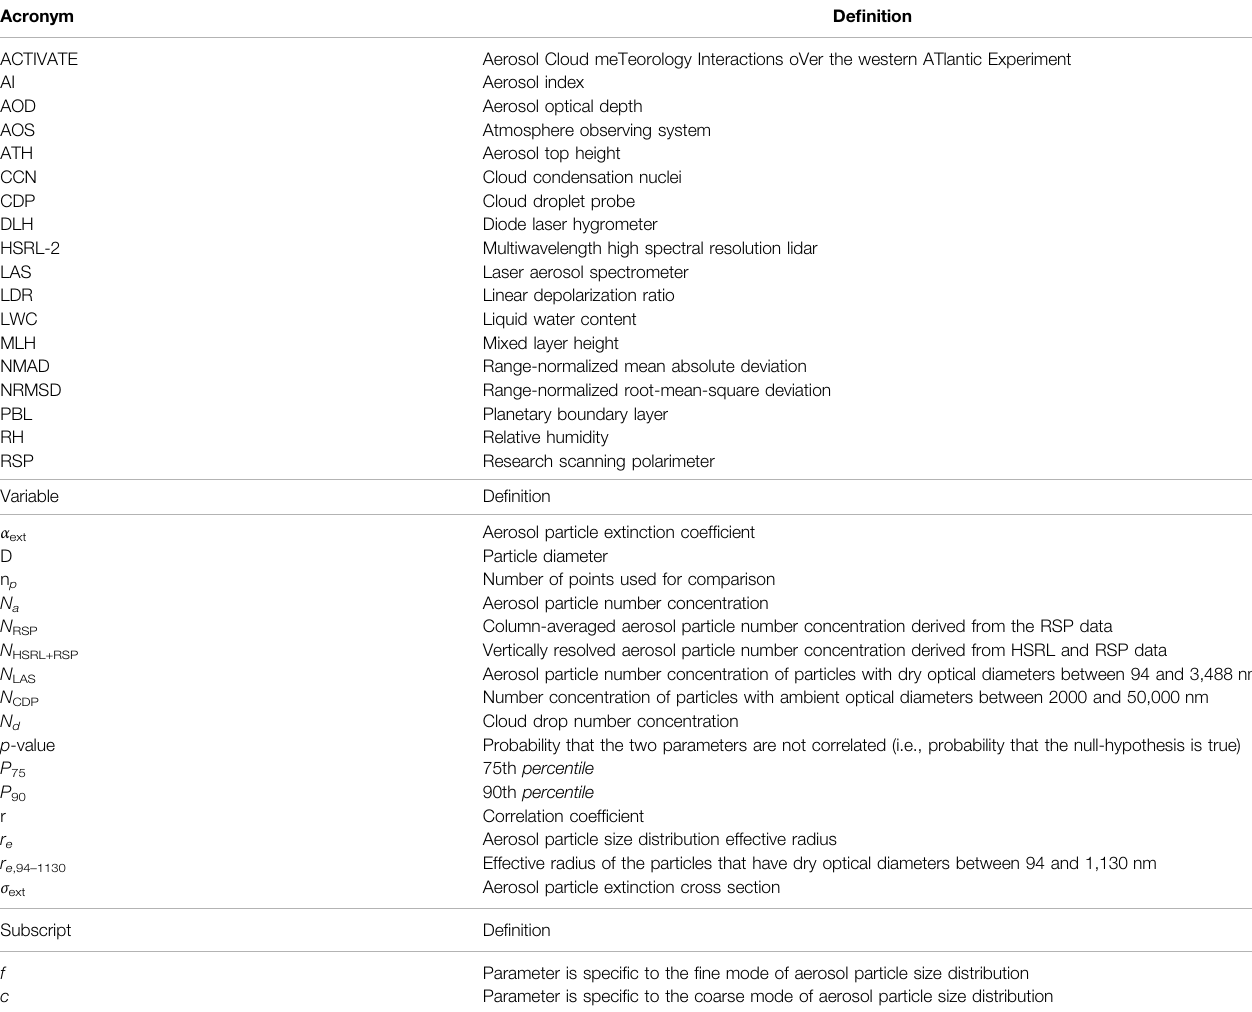
TABLE 1 | De fi nition of acronyms, variables, and optional subscripts used to mark mode-speci fi c parameters in alphabetical